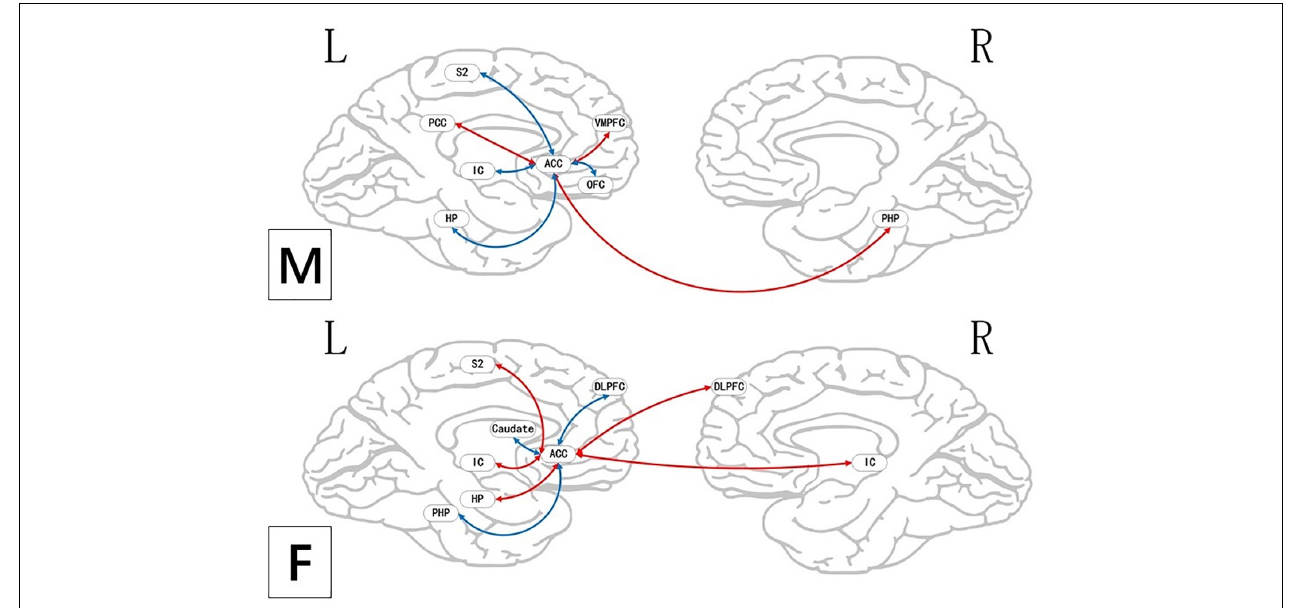
FIGURE 5 | Brain areas indicating functional connectivity state differences in the two groups, when male or female participants (placebo response) compare their own pain status. M: Compared with female participants, male participants of placebo response had unique functional connectivity in placebo response; F: compared with male participants, female participants of placebo response had unique functional connectivity in placebo response. Some brain regions only showed projection position. Red = placebo > pain; blue = pain > placebo. L, left hemisphere; R, right hemisphere; OFC, orbitofrontal cortex; DLPFC, dorsolateral prefrontal cortex; VMPFC, ventromedial prefrontal cortex; TP, temporal pole; HP, hippocampus gyrus; PHP, parahippocampal gyrus; pgACC, pregenual anterior cingulate cortex; IC, insular; MCC, mid-cingulate cortex; PCC, posterior cingulate cortex; THS, thalamus; SMA, supplementary motor area; S1, primary somatosensory area; S2, secondary somatosensory area; AG, angular